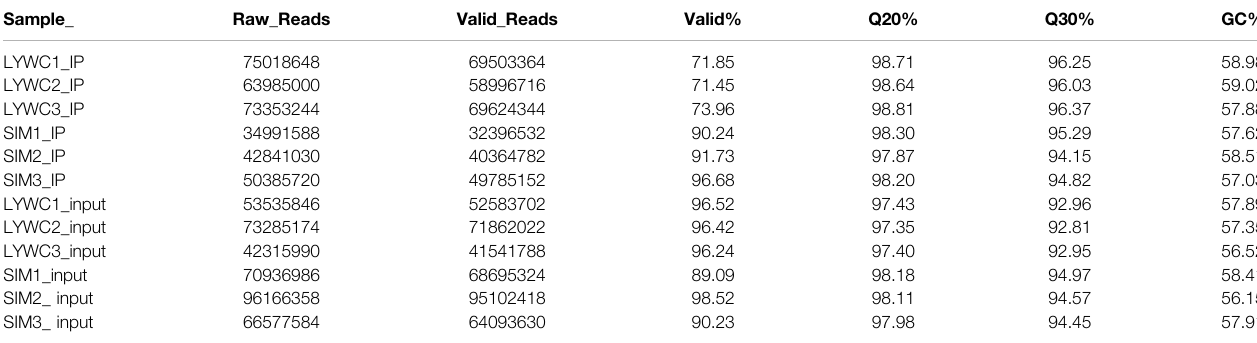
TABLE 2 | Summary of reads quality control.